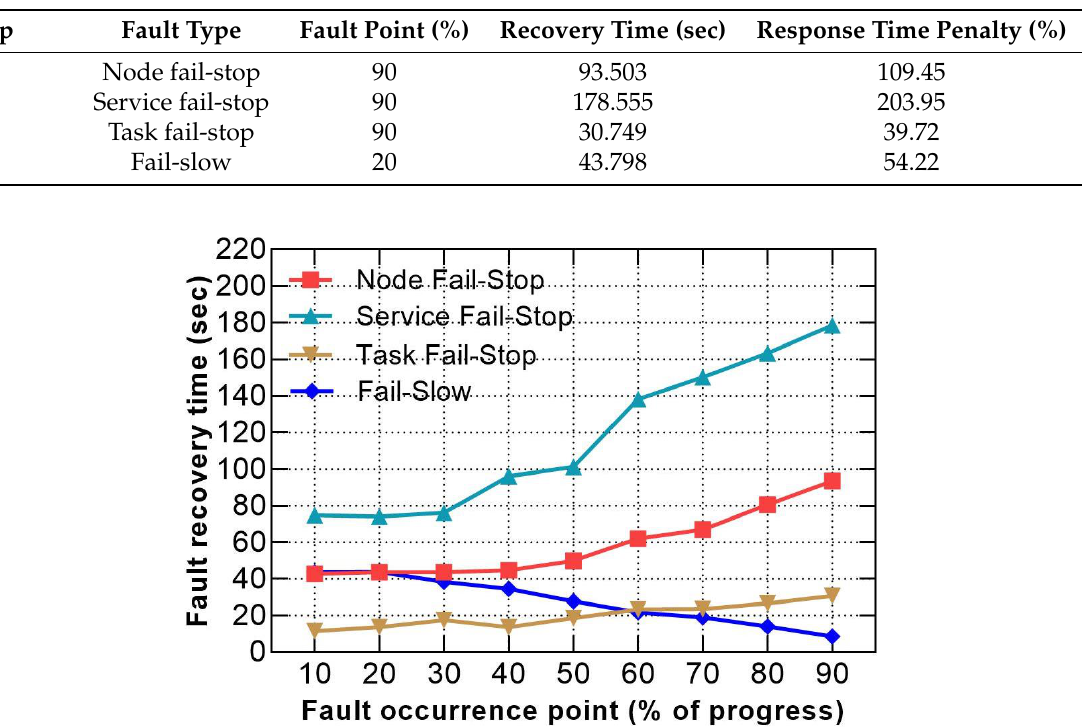
Figure 14. Recovery times when using small timeout and injecting faults at various